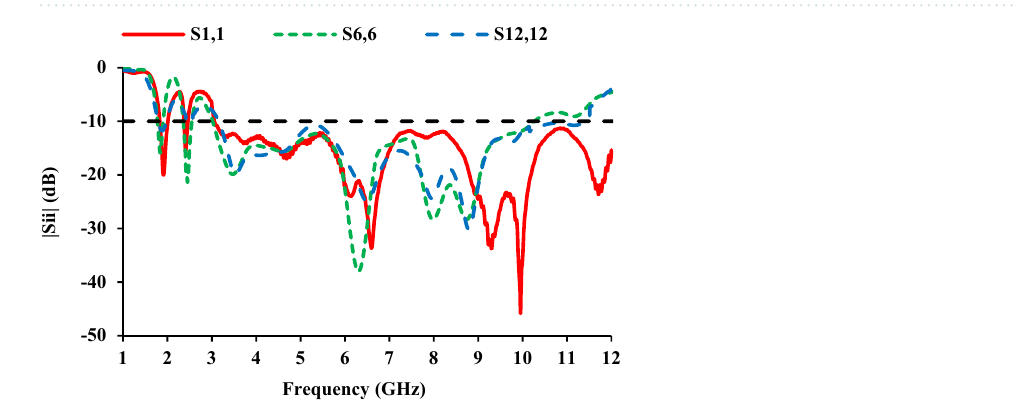
Figure 8. Proposed twelve-port MIMO antenna: ( a ) layout and ( b ) measurement of the fabricated prototype in an anechoic chamber.